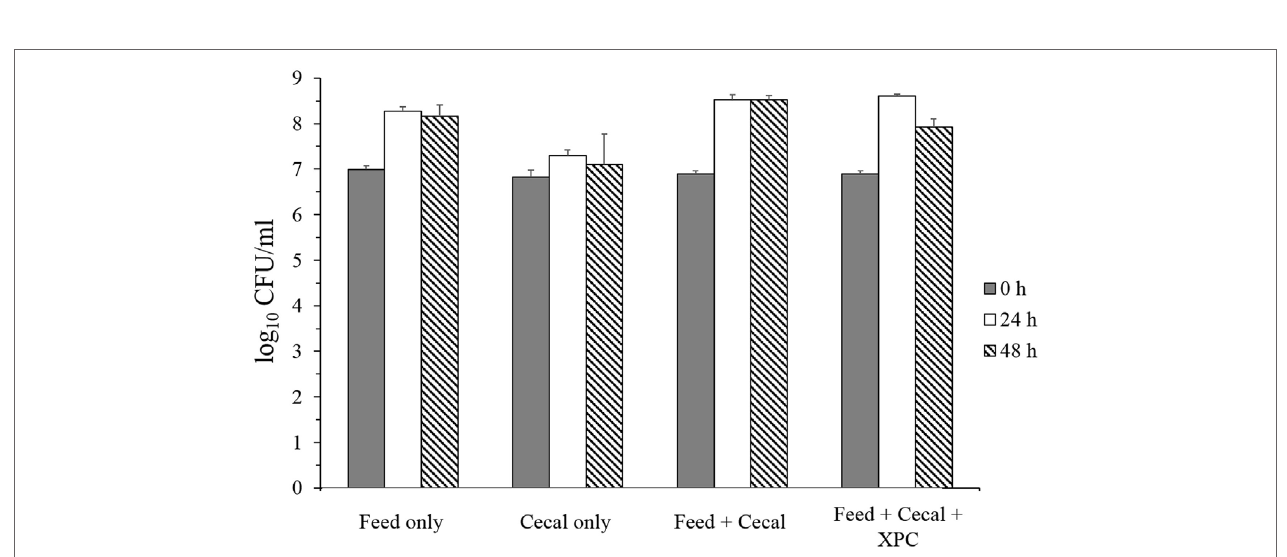
FigUre 2 | Salmonella Typhimurium survival in unadapted anaerobic cultures (group 1) with and without fermentation metabolites of Original XPc . Bars and brackets represent the mean and SE of three biological replicates.